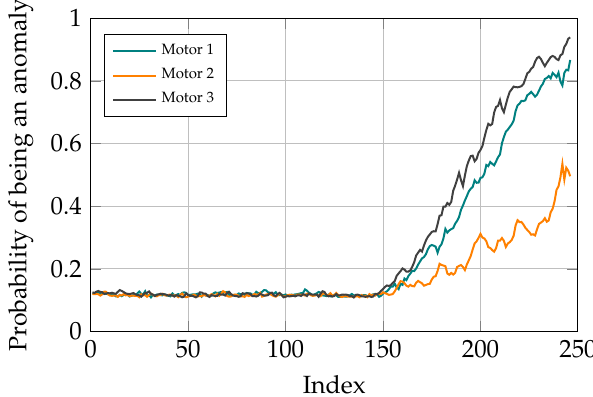
Figure 16. Simulation results with distortion added to motors 1 and 3.